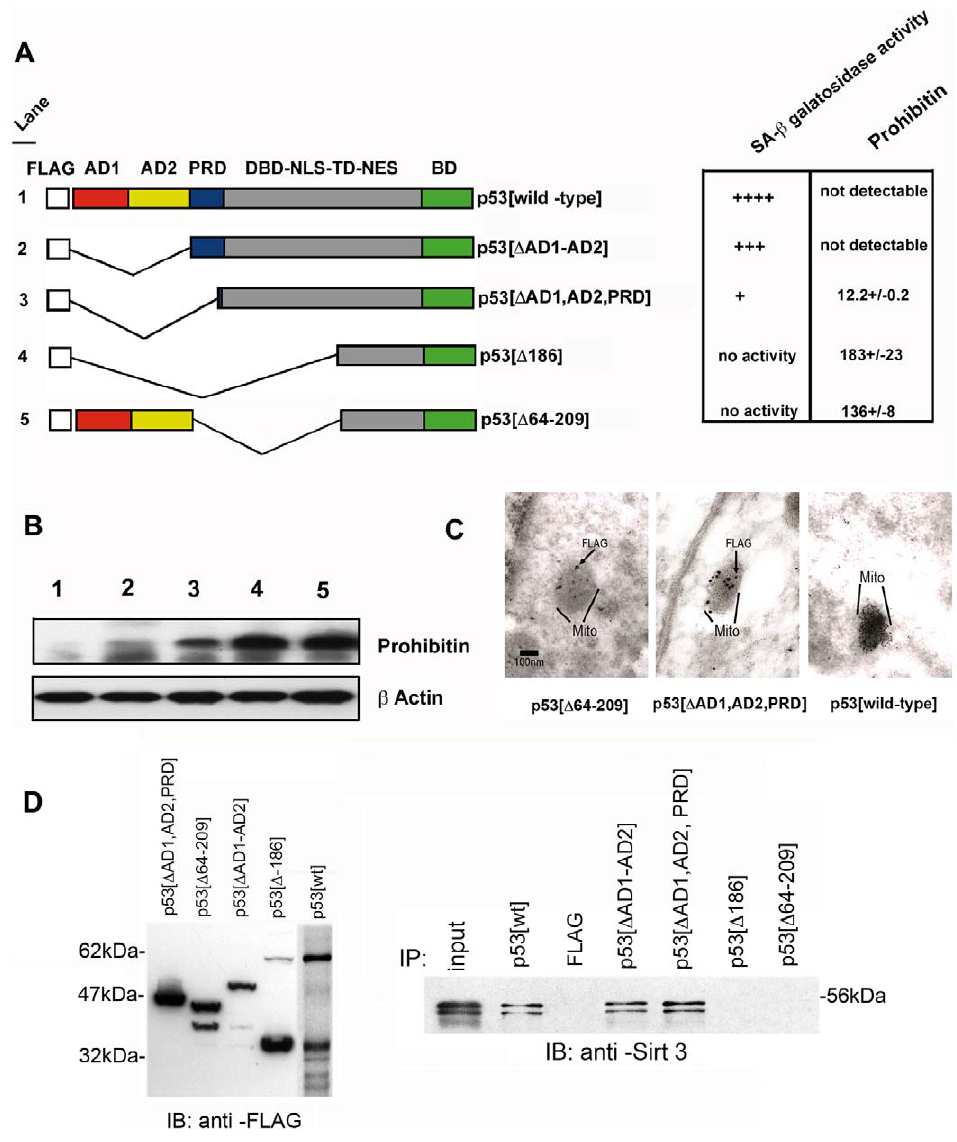
Figure 2. Deletion of p53 identifies the novel mitochrondria -associated senescence domain (MASD) between amino acids 64 and 209 of p53. ( A ) Various deletions of FLAG –tagged p53 were used to determine involvement in mitochrondria –associated senescence programs in EJ-p53 cells. The following abbreviations were used to characterize individual domains within p53 as, AD1, activation domain 1; AD2, activation domain 2; PRD, proline rich domain; DBD-NLS-TD-NES, combined DNA binding domain-nuclear localization signal-transactivation domain-nuclear export signal; BD, basic domain. Following the transient transfection of individual p53 constructs into the uninduced EJ-p53 cells, expression of p53 protein levels were normalized versus cell number to measure the level of SA - b galactosidase activity by staining with Xgal. ELISA analysis was then performed using antisera against human prohibitin (Research Diagnostics, Inc.). Colormetric analysis was then used to measure the amount of SA- b galactosidase activity ELISA was performed to measure prohibitin levels (fg/ml lysate) and normalized by the amount of immunoprecipitated FLAG- tagged p53 protein used as input from the ELISA assay. ( B ) Immunoblot analysis was then performed with anti –prohibitin nitrocellulose filter was reused to immunoblot with an anti- b actin polyclonal antisera (Sigma-Aldrich). ( C ) Electron micrograph (10,000X) of EJ carcinoma cells transfected with the different FLAG-tagged and truncated variants of human p53 and stained with the anti-FLAG monoclonal antibody (Sigma-Aldrich). Region corresponding to the outline of the mitochrondria is indicated. ( D ) Interaction of Sirt3 with the MASD region of p53. Using FLAG-tagged variants of the deleted p53 cDNAs expressed by transient transfections of p53 shown (left) were used to identify specific interactions with endogenous Sirt3 by immunoprecipitation with M2 agarose (Sigma-Aldrich) followed by standard immunoblotting